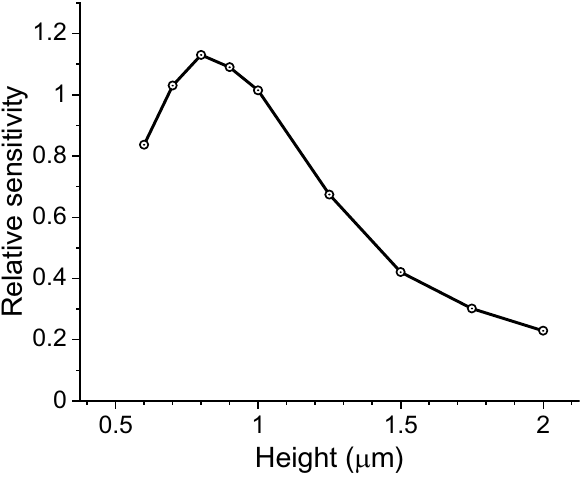
Figure 5. Sensitivity vs waveguide thickness T at n = 2, which corresponds to the SiN material.